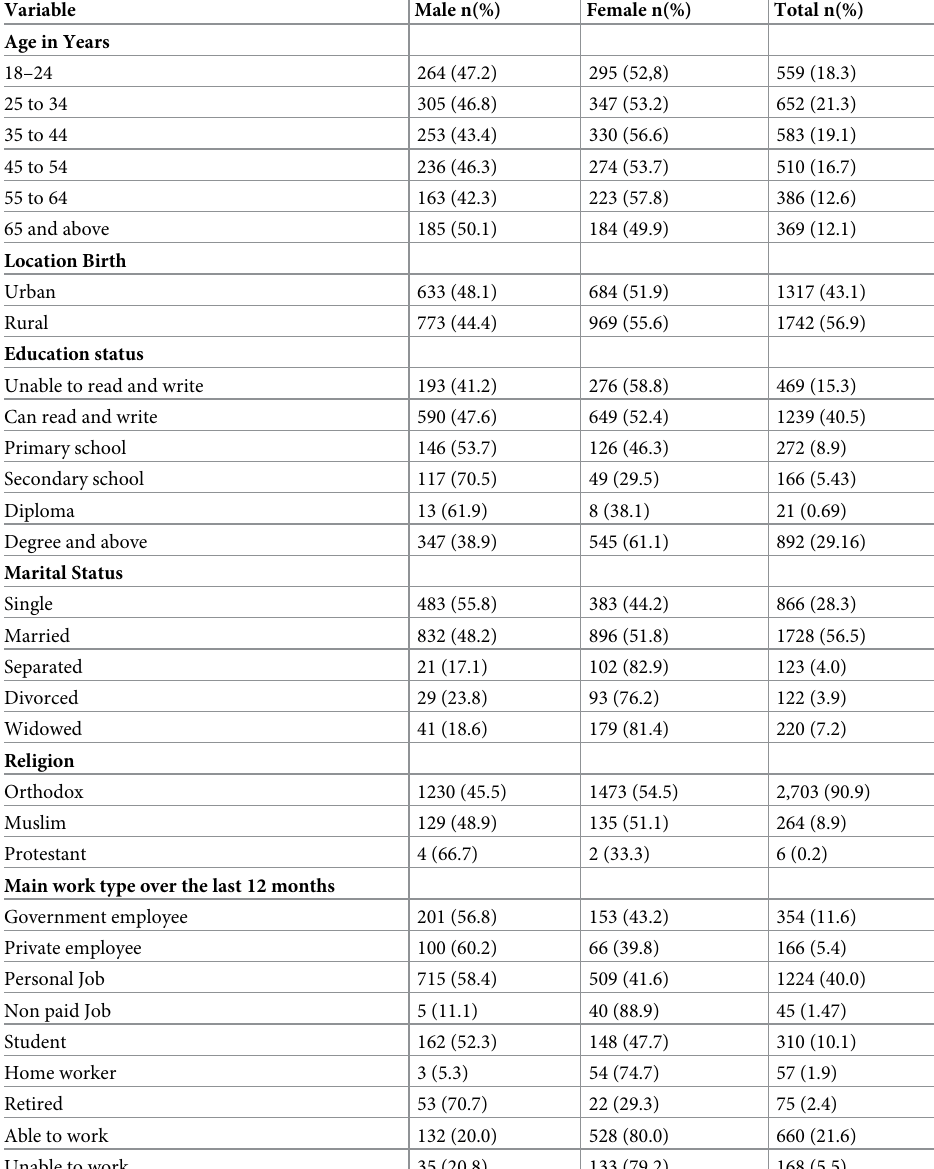
Table 1. Socio- demographic and clinical characteristics of the study population by sex in a community-based sur- vey among Gondar city residents who were � 18 years old, Northwest Ethiopia.